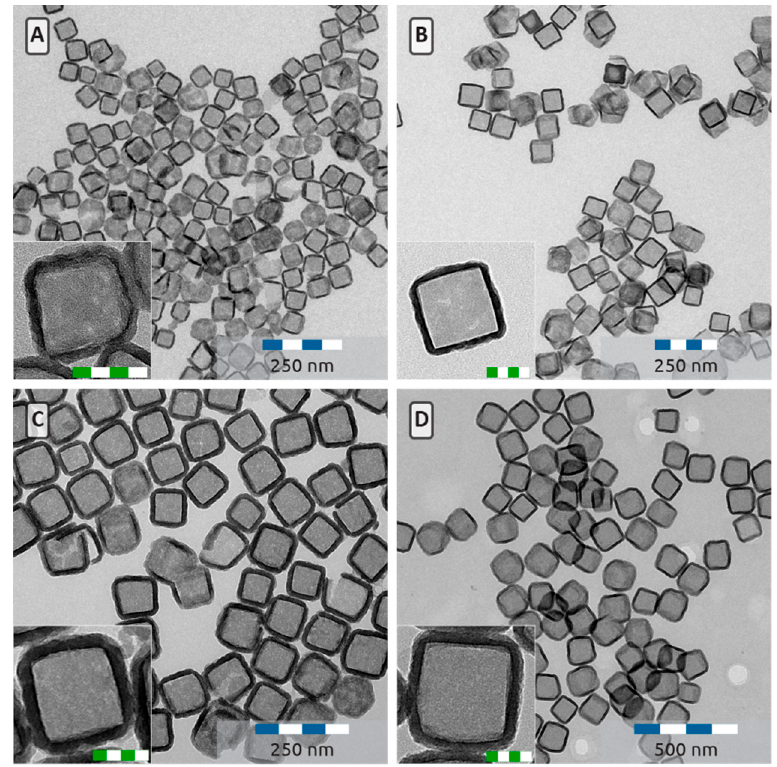
Figure 8. Hollow silica nanocubes with an edge length of 76 ± 7 nm ( A ), 96 ± 8 nm ( B ), 118 ± 11 nm ( C ) and 150 ± 13 nm ( D ) Insets are higher magnification micrographs. Scale bars in the insets are 50 nm.